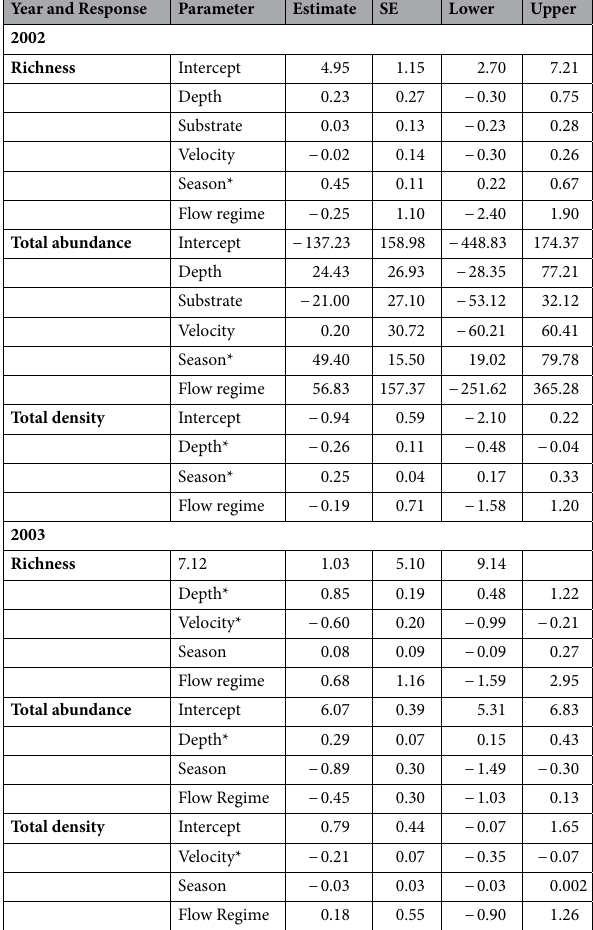
Table 4. Model averaged parameter estimates, standard error, lower and upper 95% CI by year and response variable. Model averaging was done for top models (AICc < 2) for each species. Parameter estimates with 95% CI not overlapping zero are considered significant and marked with an